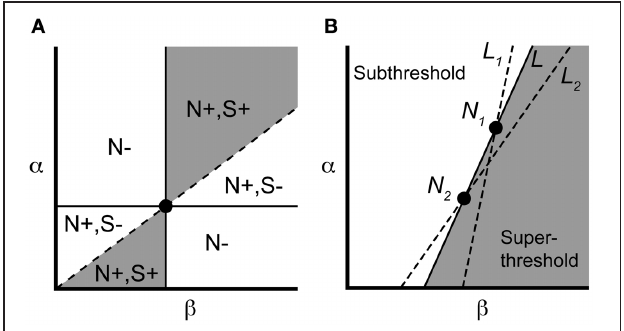
FIGURE 3 | Parameter space visualization of control approach. (A) A given neuron, identified by its values for α and β ( dot ), will be pairwise controllable with any neuron satisfying the necessary [ N+ ; Equation (2) ] and sufficient [ S+ ; Equation (3) ] conditions (region shown in gray ). (B) Two neurons N 1 and N 2 can be made to spike simultaneously under the input Equation (7) , along with any neuron lying along the line L (see text). Neurons to the left of L will remain subthreshold, while neurons to the right will spike. If we instead choose input Equation (7) corresponding to lines L 1 or L 2 , we selectively elicit a spike from neuron 1 or 2, respectively, along with overlapping but distinct subensembles of neurons (to the right of the chosen